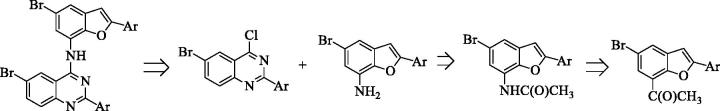
Design of benzofuran-amino quinazolines using molecular hybridization approach.